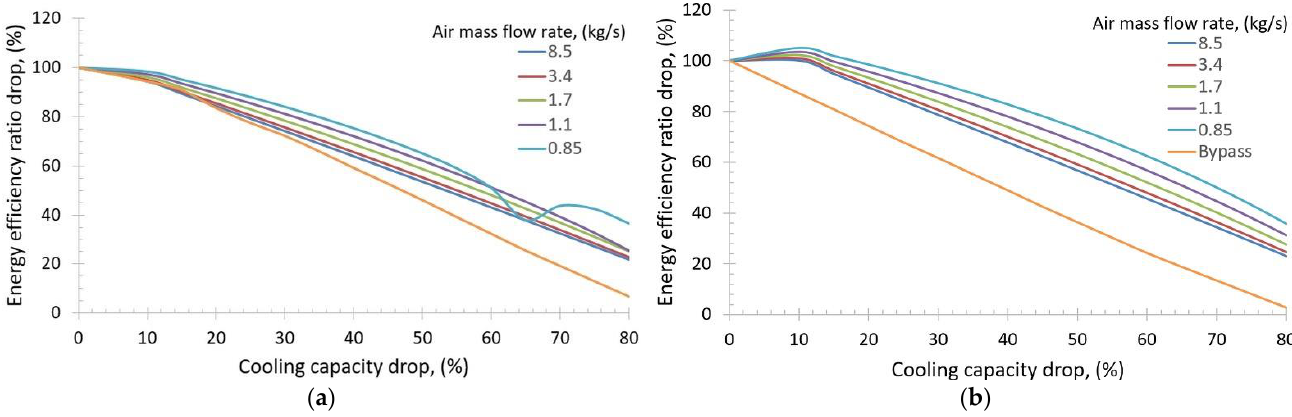
Figure 10. Relative energy efficiency ratio in the function of cooling capacity drop for different air mass flow rates (additional